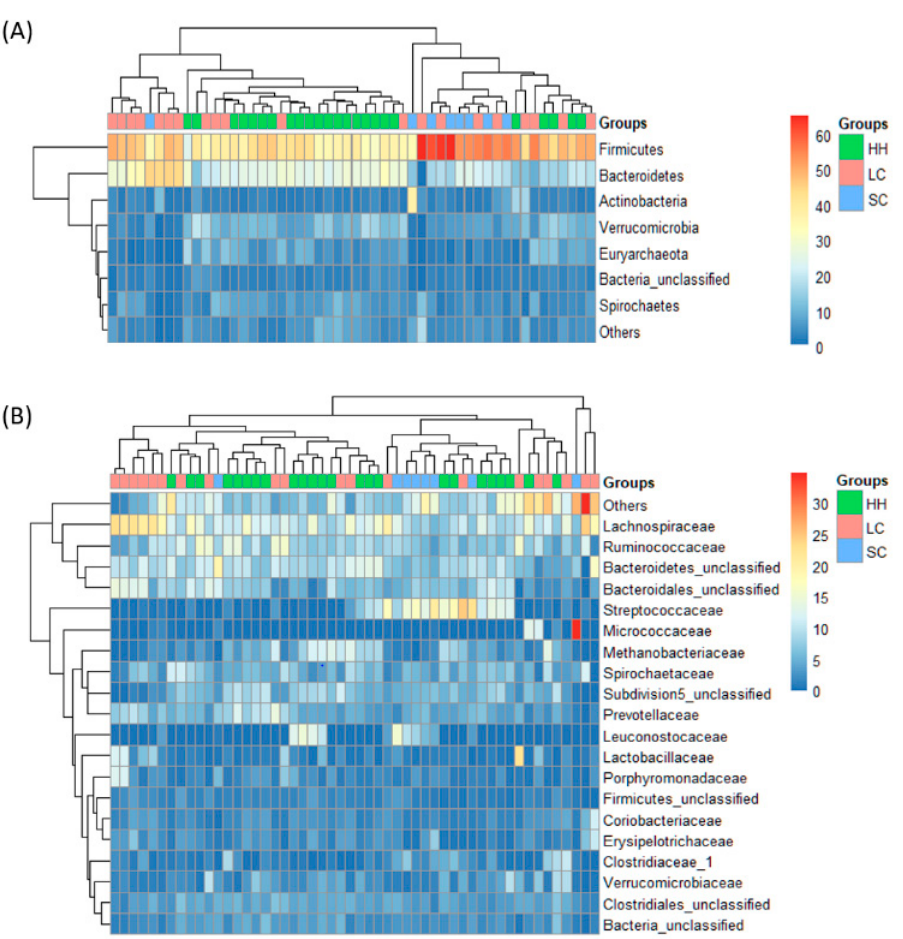
Figure 3. Comparison of the horse fecal microbiota bacterial composition at the phylum ( A ) and family ( B ) level. HH, healthy horses; LC, horses with large intestinal colic; SC, horses with small intestinal colic.